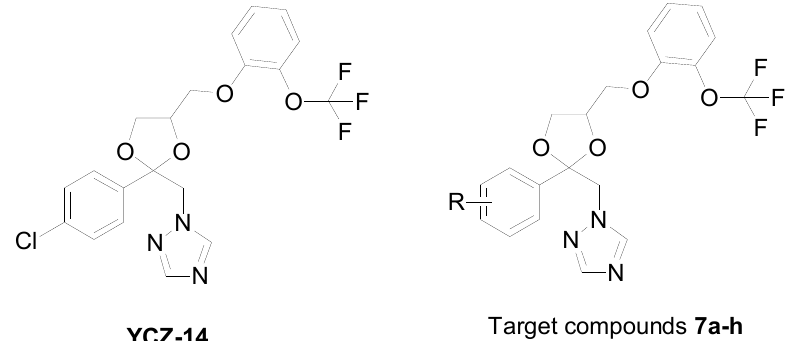
Target compounds